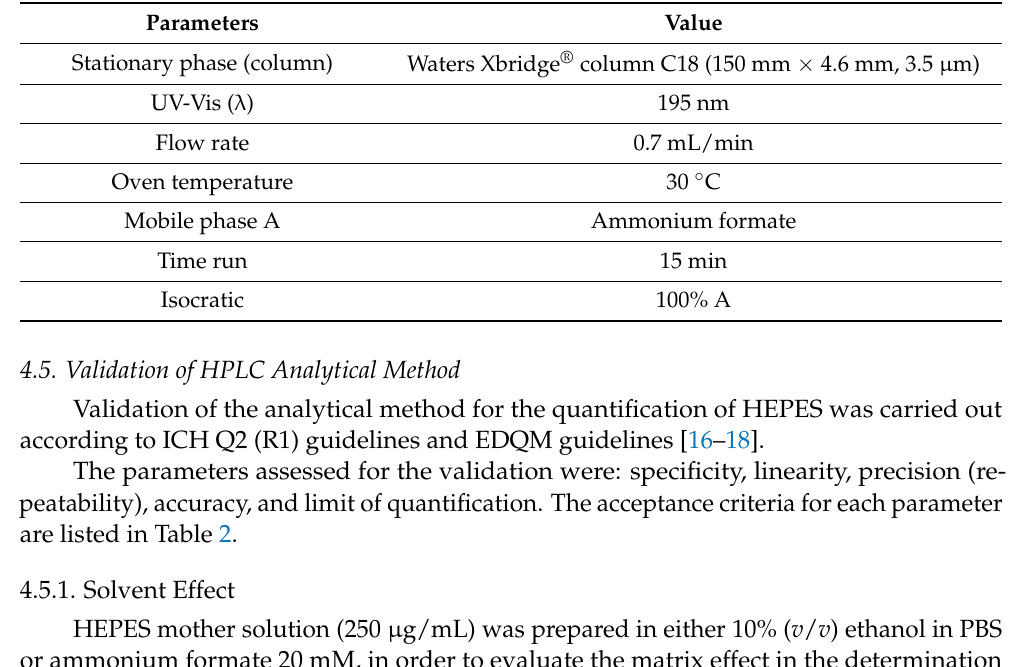
Table 4. HPLC parameters and values for the quantification of HEPES. The UV-HPLC method was validated according to the regulatory requirements